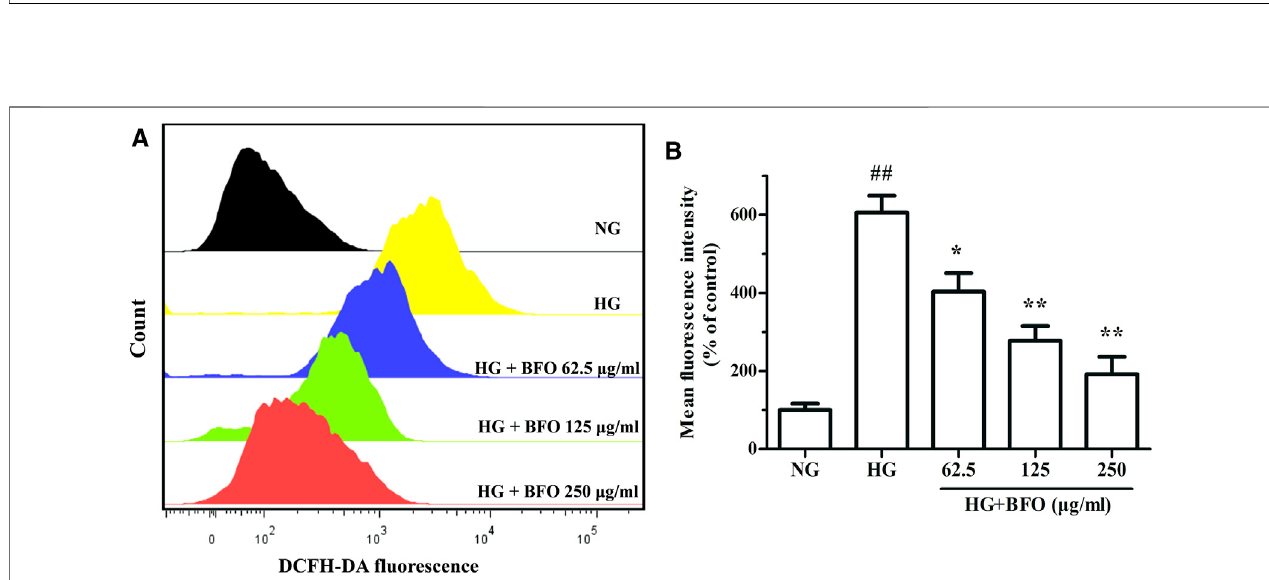
FIGURE 4 | Effect of BFO on the level of reactive oxygen species (ROS) in NRK-52E cells. (A) Representative images of ROS generation measured by fl ow cytometry usingtheDCFH-DAprobe. (B) Histogram representingthequantitativeanalysisofROSaccumulation inNRK-52Ecells.All dataareexpressed asthemean ± SD. ## p < 0.01 vs. normal glucose (NG), * p < 0.05 vs. HG, ** p < 0.01 vs. HG.